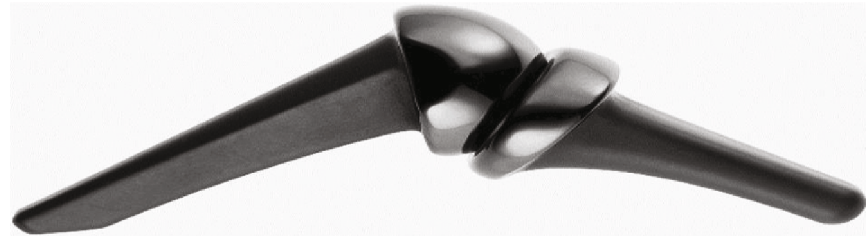
Figure 7: The ascension